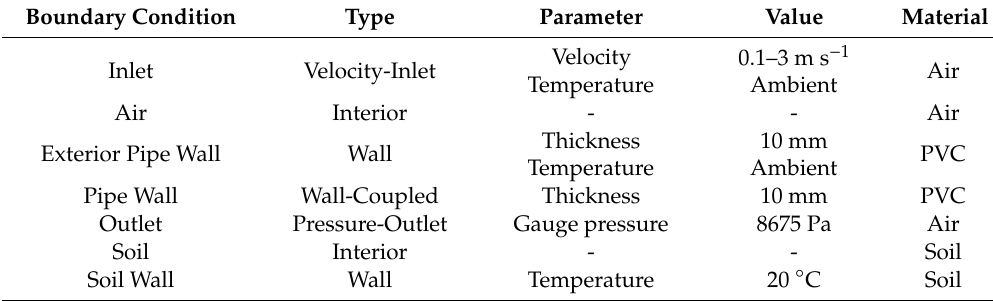
Table 1. Boundary conditions of the model.